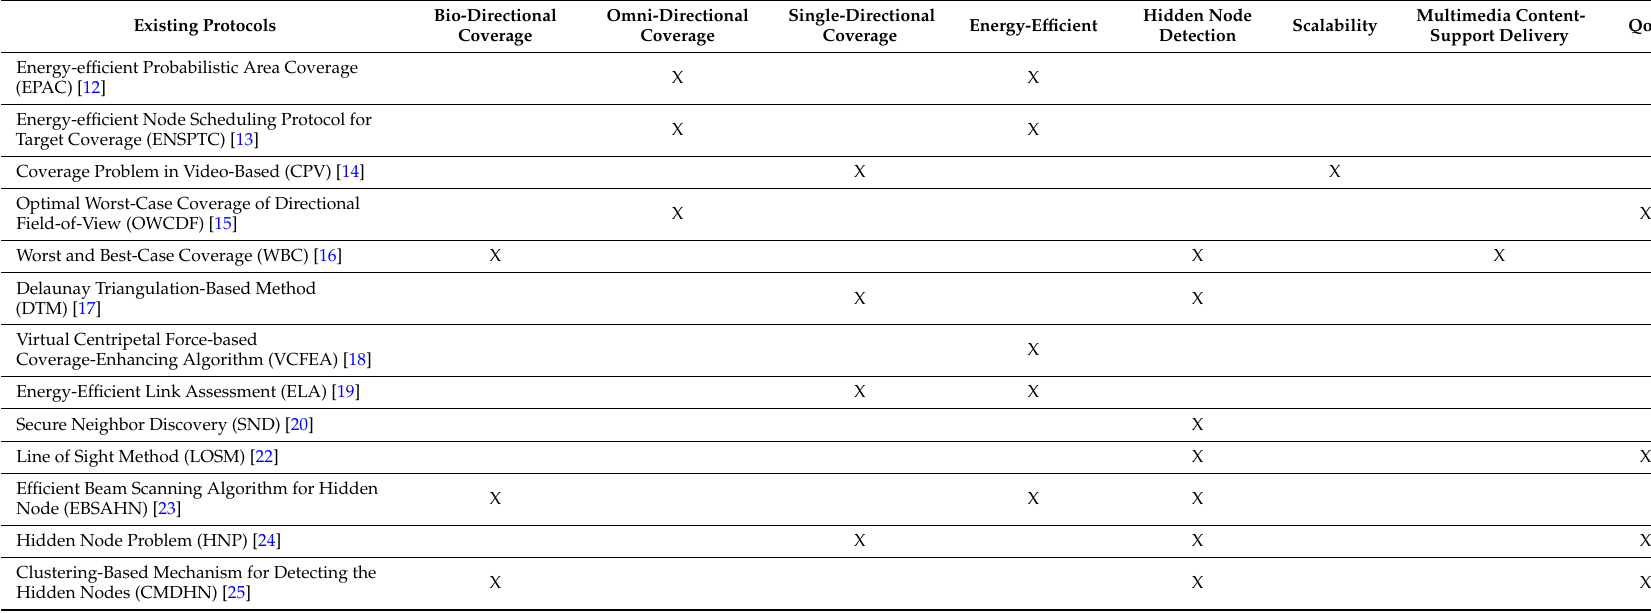
Table 1. The characteristics and limitations of the existing